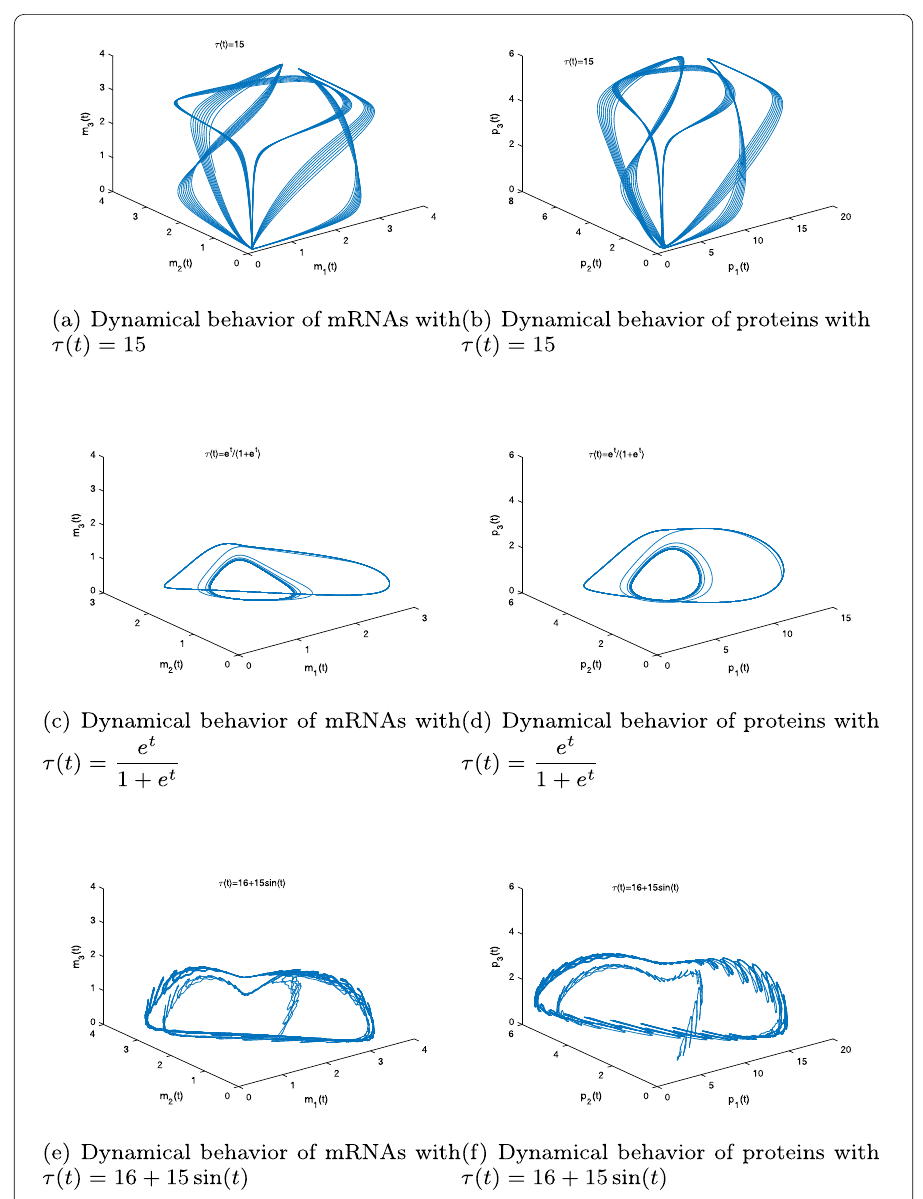
Figure 2 Dynamical behaviors of GRN (1) with different time